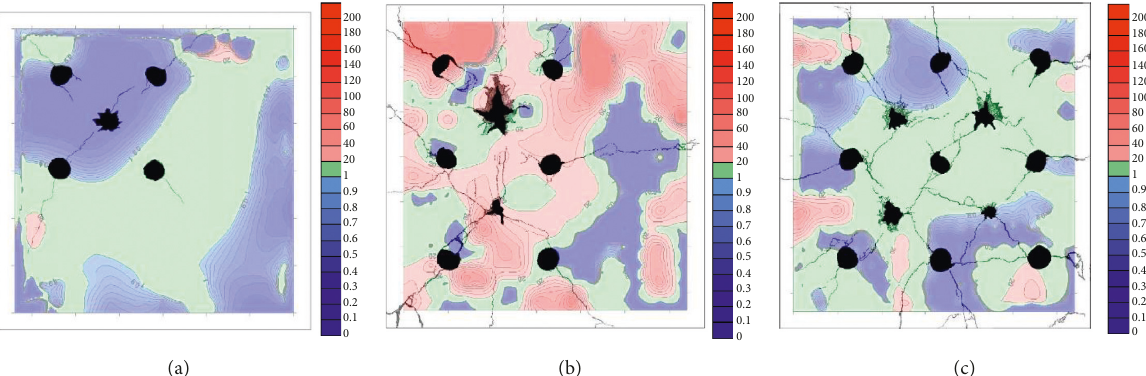
Figure 12: Crack and electrical resistivity after blasting. (a) Single-hole blasting model. (b) Double-hole blasting model. (c) Four-hole blasting